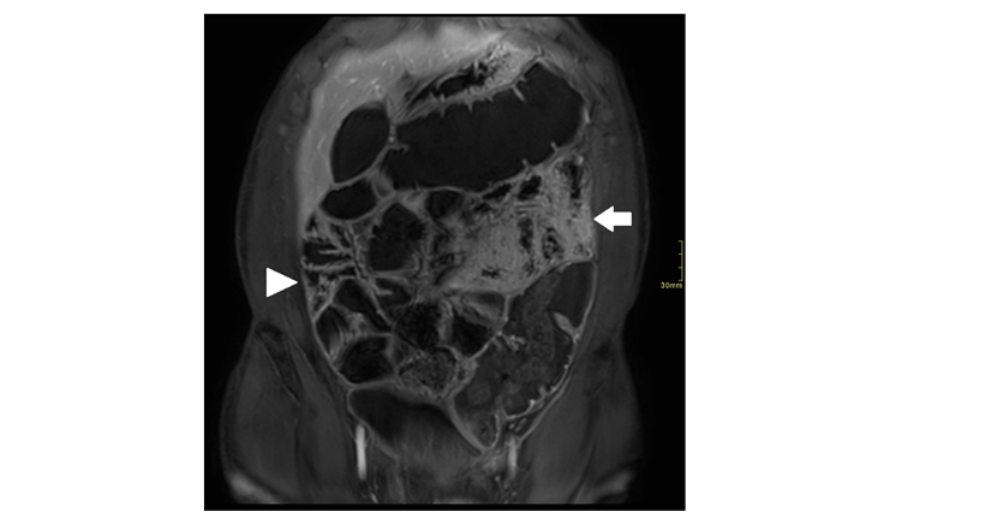
Figure 1. Coronal fat ‐ suppressed T1 post ‐ contrast sequence of a 61 ‐ year ‐ old male with small bowel CD; suboptimal distension and marked motion artifacts in proximal small bowel (arrow); optimal distension and minor motion artifacts in distal small ball (arrowhead).